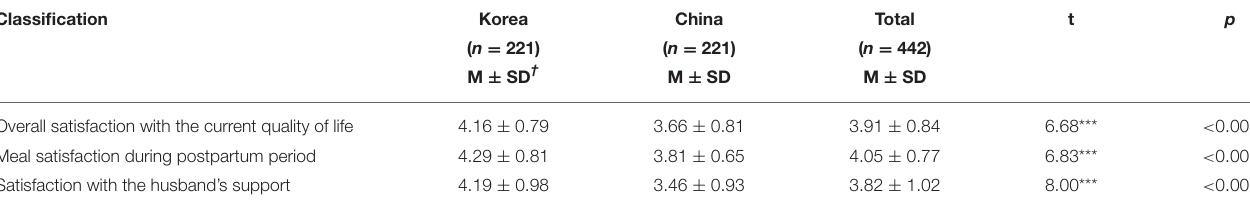
TABLE 3 | Comparison of life satisfaction among Korean and Chinese postpartum women.